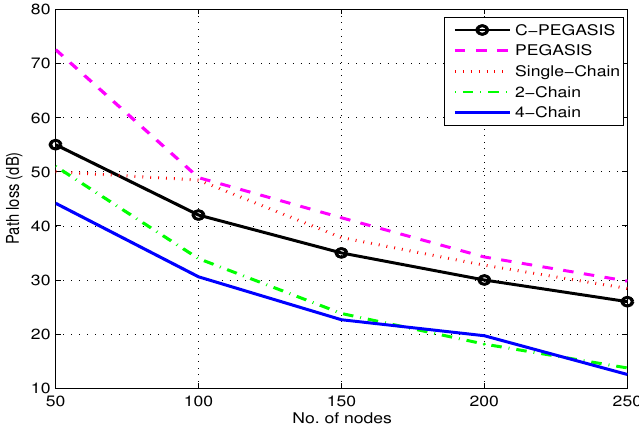
Figure 14. Impact of node density on path